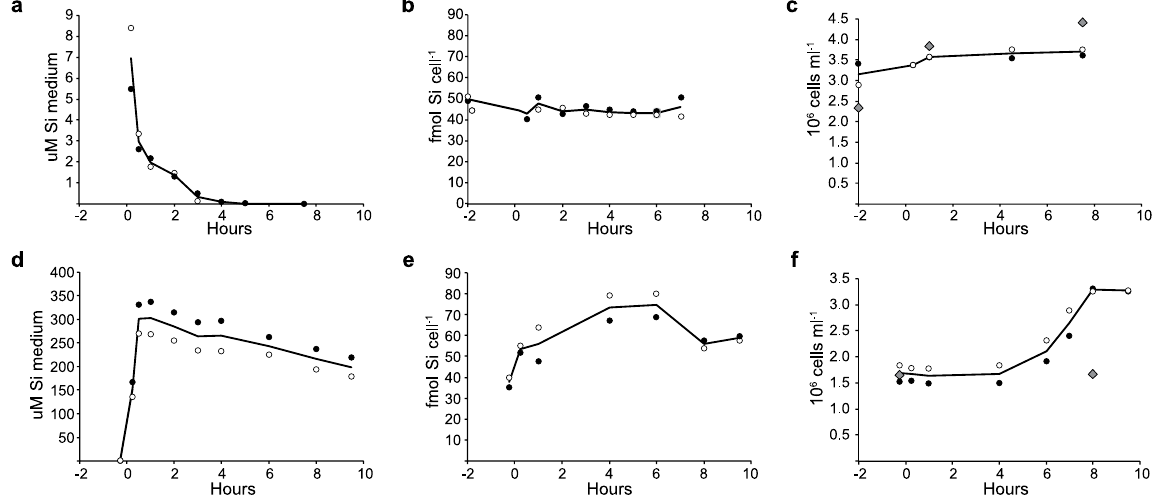
Figure 1. Cell growth and Si content in T. pseudonana cultures during silicon shift-down ( a – c ) and silicon shift-up ( d – f ). ( a , d ) Si concentration ( μ M) in the growth medium. ( b , e ) Total particulate Si (fmol cell − 1 ). ( c , f ) Cell numbers (cells ml − 1 ). Two biological replicates (open and closed circles) and average (bold line) are shown. Grey diamonds ( c and f ) are cell counts from a control